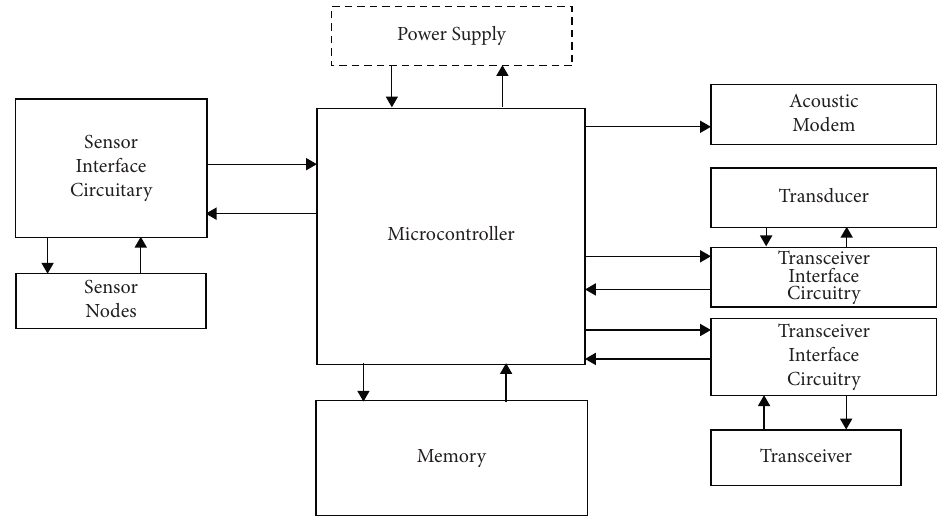
Figure 3: Internal architecture of sensor networks for underwater wireless